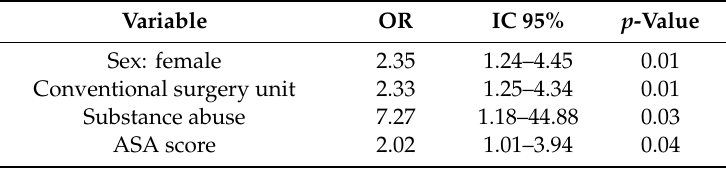
Table 4. Multivariate analysis: significant risk factors for RA